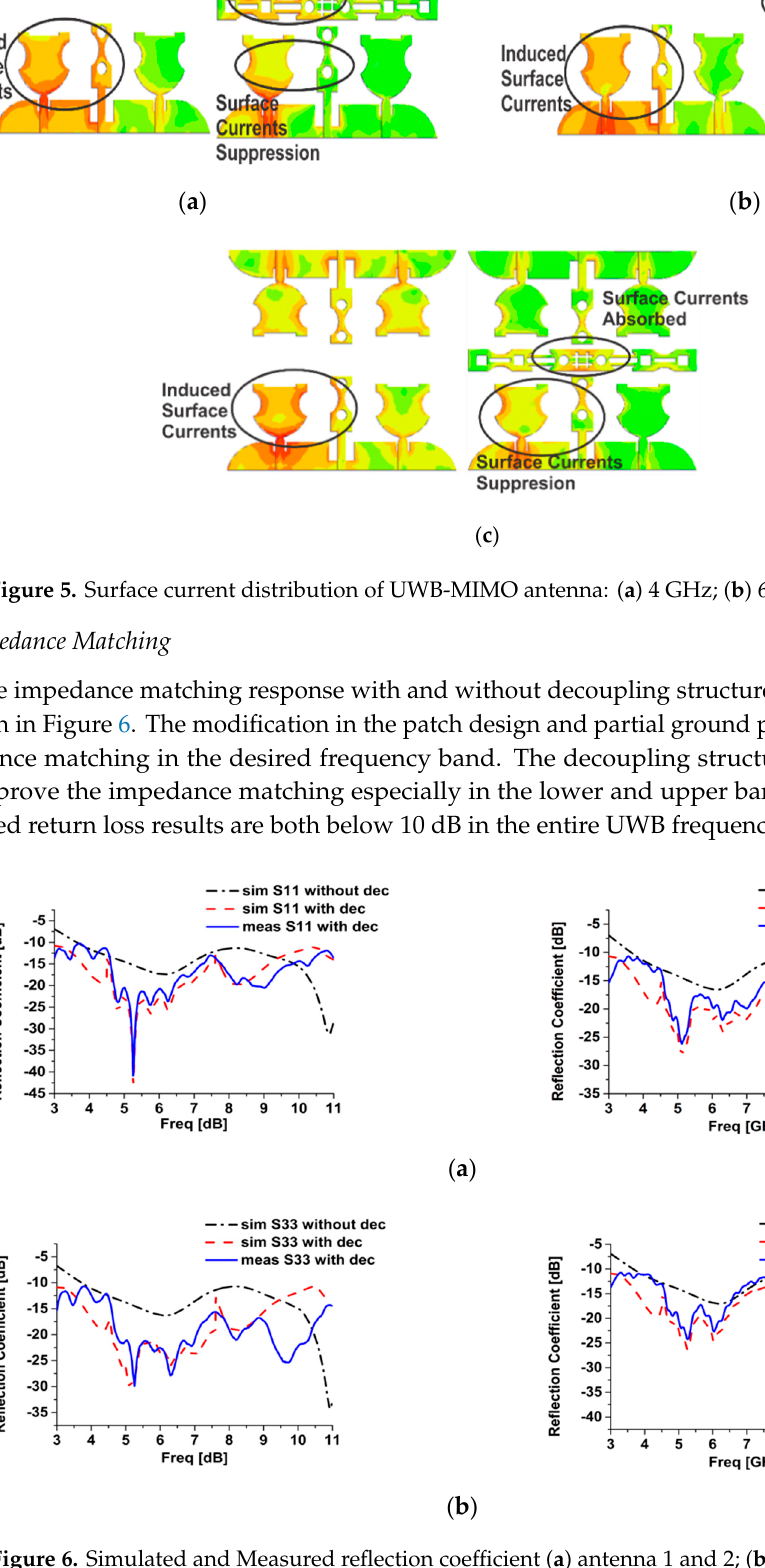
( b ) Figure 4. Analysis. ( a ) Analysis setup; ( b ) transmission loss. 4. Results and Discussions 4.1. Induced Surface Currents The surface currents at 4 GHz, 6 GHz and 10 GHz are shown in Figure 5. Only one antenna element is made to radiate and others are terminated at matched impedance in order to observe the effect of radiation. There are strong induced surface currents on the non-radiating elements which are caused by coupled fields. Both side and facing elements develop these induced currents. The introduction of decoupling structure helps in suppressing these coupling, in Figure 5a the current plot at 4 GHz is shown and it can be observed that the coupled currents are now visible on the outer section of the decoupling structure which means that these sections resonate at lower frequency which is supported by Figure 4b as well. Likewise the current plot at 6 GHz is shown in Figure 5b